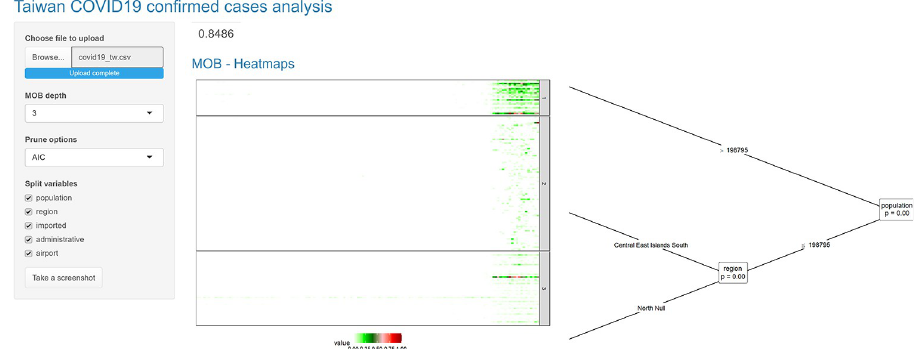
Fig 1. Clustering and forecasting Taiwan COVID-19 confirmed infection cases—Part 1.